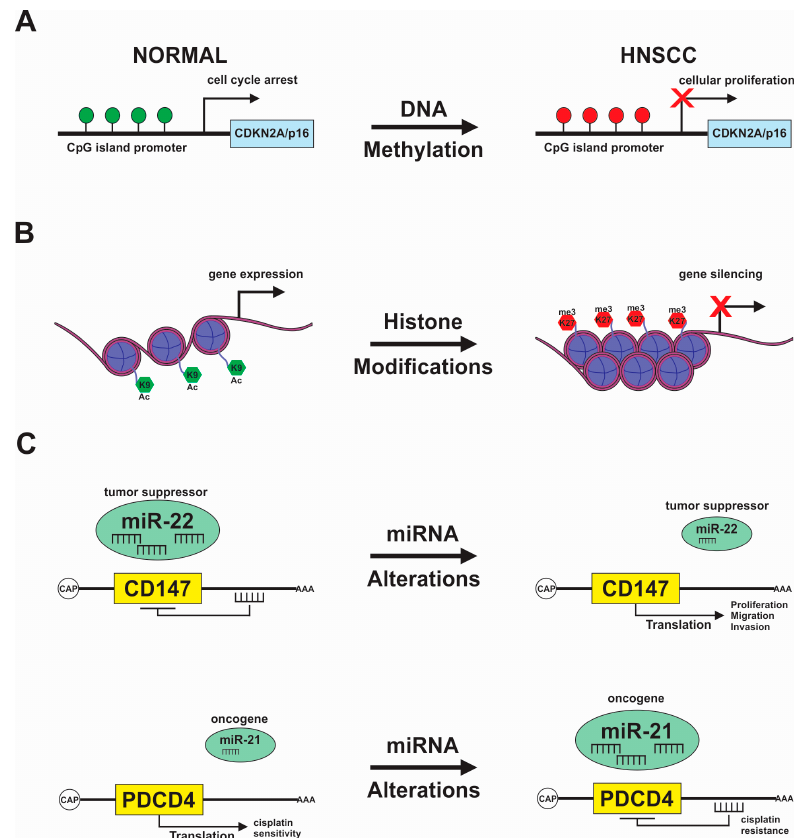
Figure 2. Overview of epigenetic alterations involved in the HNSCC progression and resistance to therapy. ( A ) DNA hypermethylation of the tumor suppressor CDKN2A/p16 INK4a is the most frequent epigenetic modification observed in HNSCC, leading to cellular proliferation; ( B ) Changes in the chromatin structure lead to histone deacetylation and methylation of lysine in the histone tails resulting in gene silencing; ( C ) MicroRNAs work as a tumor suppressor and oncogenes regulate genes involved in HNSCC tumorigenesis. miR-22 acts as a tumor suppressor, controlling the levels of CD147 and it is frequently downregulated in HNSCC, increasing processes like proliferation, migration, and invasion (upper image). miR-21 is accumulated in HNSCC, showing oncogenic characteristics by targeting PDCD4 gene increasing resistance to cisplatin treatment (lower image).